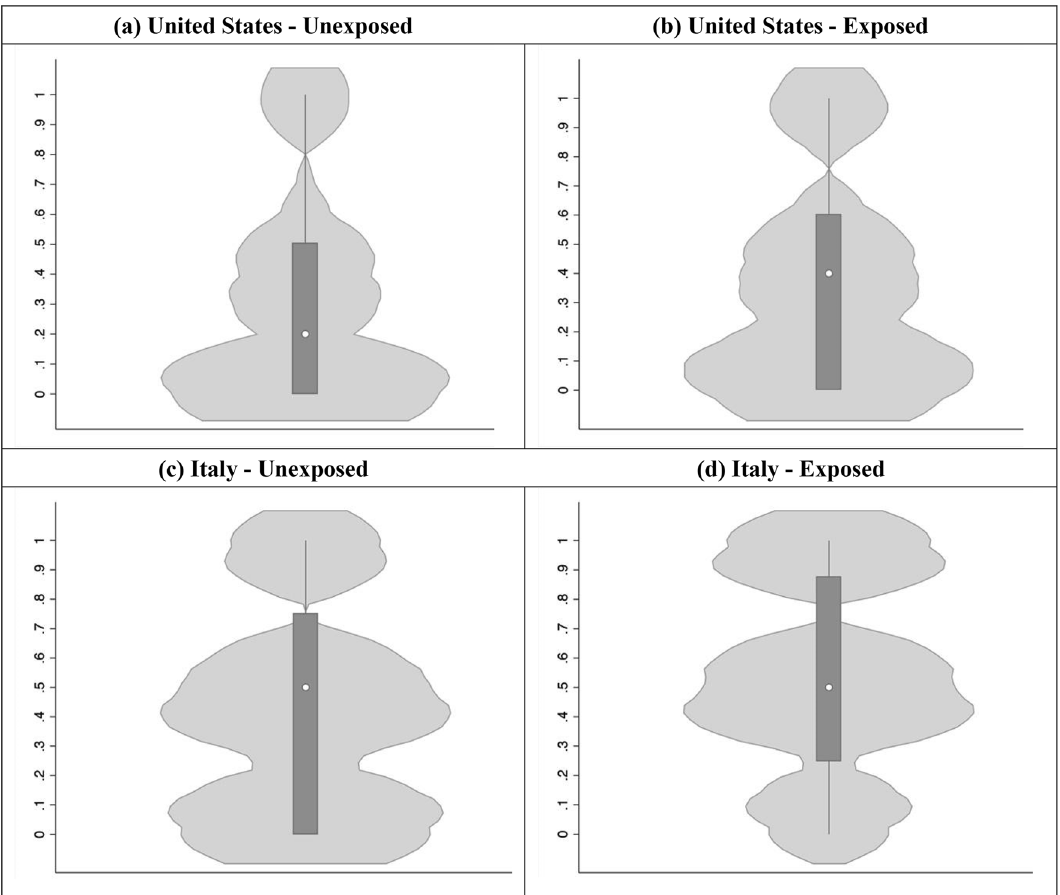
Figure 2. Distribution of amount donated by country and exposure to COVID-19. Distribution plots include a white point indicating the median of the distribution, a box indicating the interquartile range (from 25th percentile up to 75%) percentile, and spikes extending to the upper- and lower-adjacent values. Overlaid with this box plot is the density of the distribution, estimated by k-density.